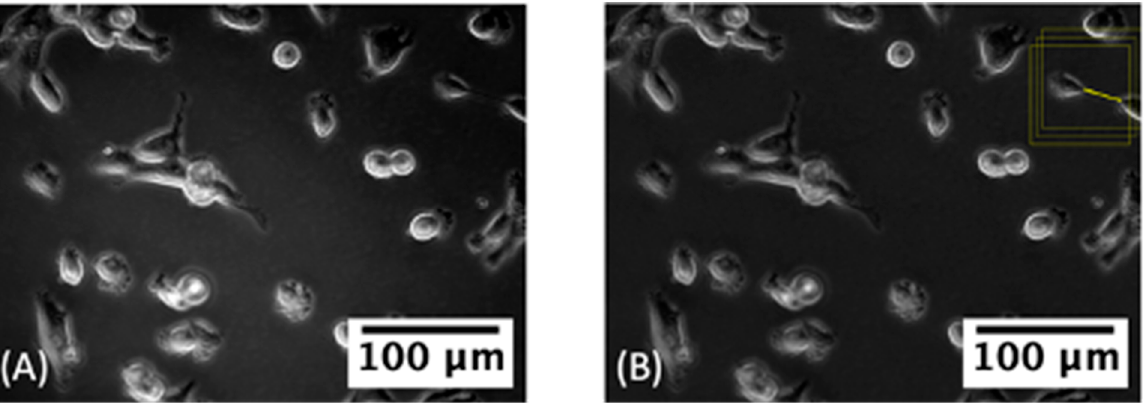
Figure 4. ( A ) Original image containing large pockets of TNT-free spaces. ( B ) After correcting edge artefacts as shown in Figure 2, the TNT-containing “patches” (yellow squares) showed where TNTs were captured within the matrix of smaller image regions. See Supplementary Figures S1 and S2.